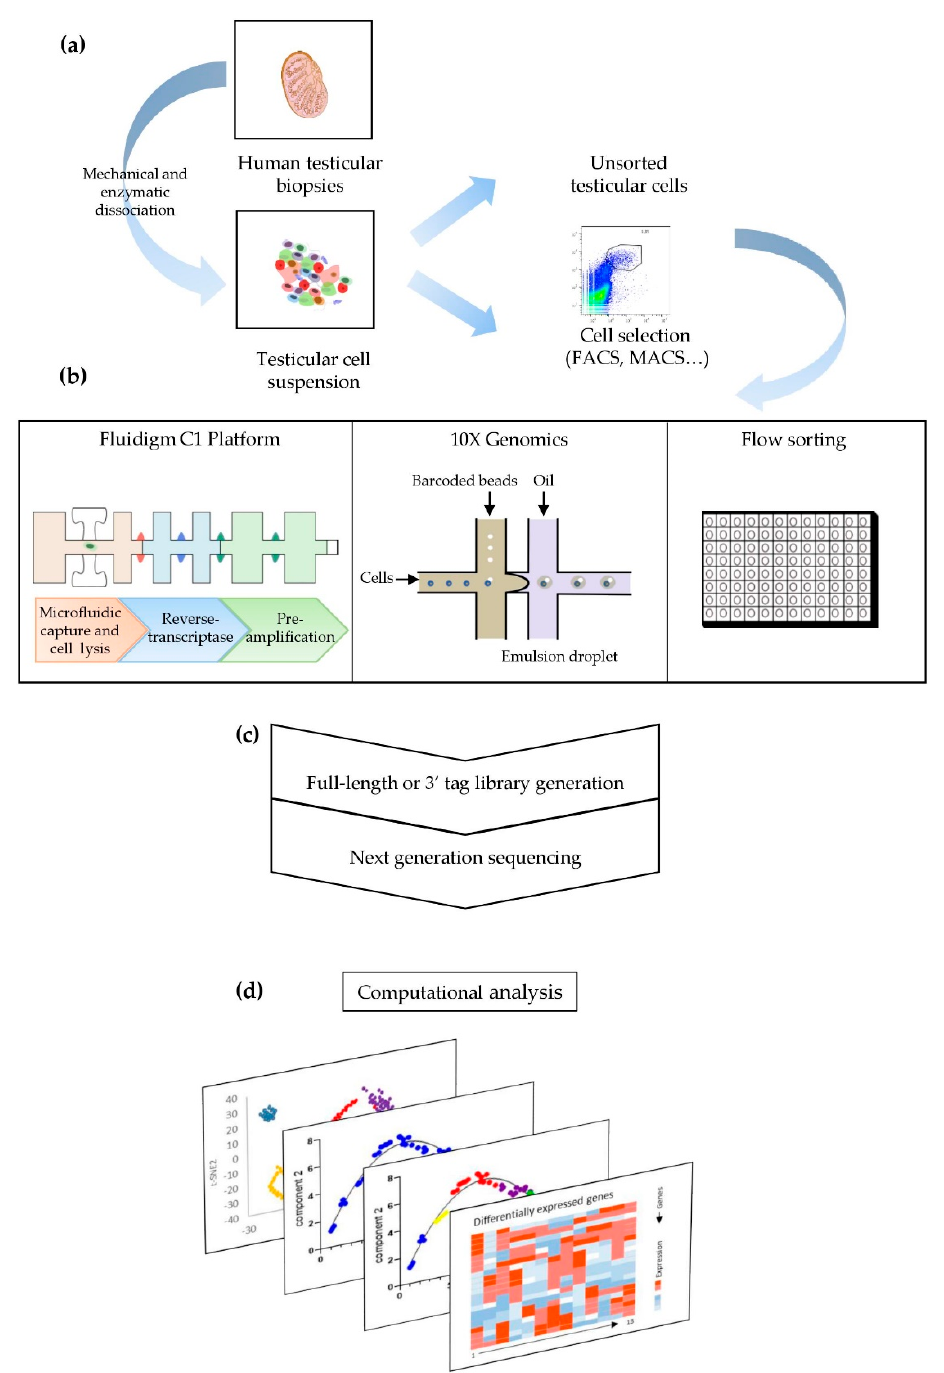
Figure 1. Single-cell transcriptome sequencing (scRNAseq) flowchart for the exploration of human spermatogenesis. ( a ) The testicular tissue is mechanically and enzymatically dissociated to get a cell suspension. The cells can either be sorted to focus on a specific cell population or directly screened for an unbiased analysis. ( b ) scRNAseq library is generated, using platforms as Fluidigm C1 or 10 × genomics, for example, via successive steps of single cell isolation, cell lysis, reverse transcription of RNA into cDNA, followed by amplification. ( c ) Next generation sequencing—Smart-seq protocol provides full-length transcriptome analyses (e.g., in C1 platform), while Droplet-sequencing approaches generate 3 ′ tag RNAseq libraries. ( d ) The raw data are computationally analyzed and structured into clusters, developmental trajectories by pseudotime analysis and networks to characterize cell subsets.